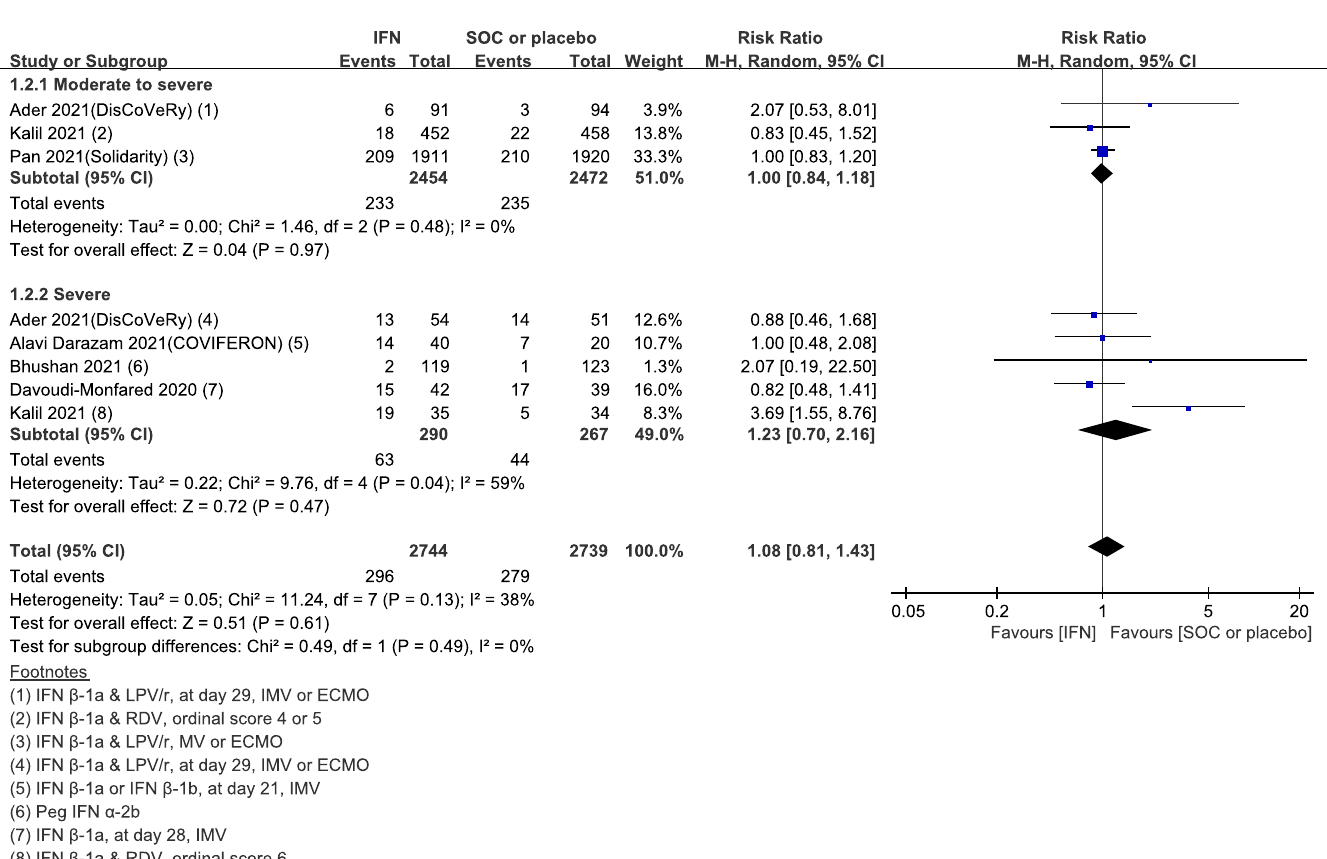
Fig 3. Forest plot of progression to mechanical ventilation. Forest plot presenting the risk ratio (RR) for progression to mechanical ventilation between the interferon (IFN)-treated and control arms. Meta-analysis of six randomized controlled trials (RCTs) comprising 5,483 patients revealed no significant difference in progression to mechanical ventilation between the IFN-treated and control arms (overall group: pooled RR = 1.08, 95% CI: 0.81–1.43, I 2 = 38%; moderate-to-severe group: RR = 1.00, 95% CI: 0.84–1.18, I 2 = 0%; severe group: RR = 1.23, 95% CI: 0.70–2.16, I 2 =